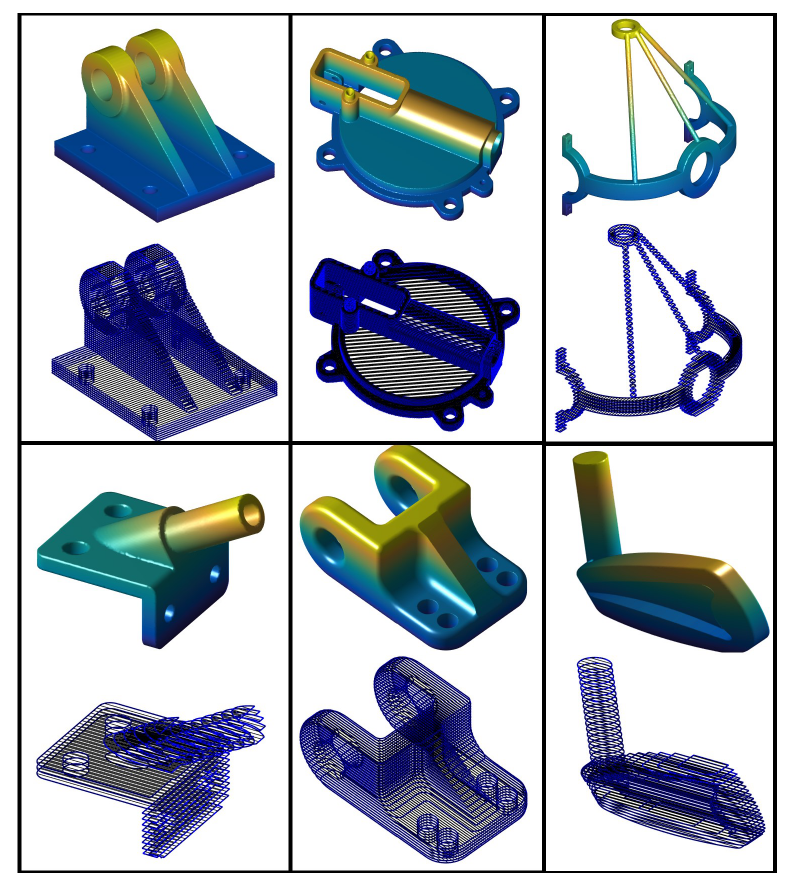
Figure 10. Mesh slicing of benchmark weak-Morse CAD datasets. Our algorithm computes the level sets (slices). As a test for our level sets, they are then fed to another algorithm (not part of this manuscript) which correctly generates the tool paths for Additive Manufacturing. Datasets from the National Design Repository